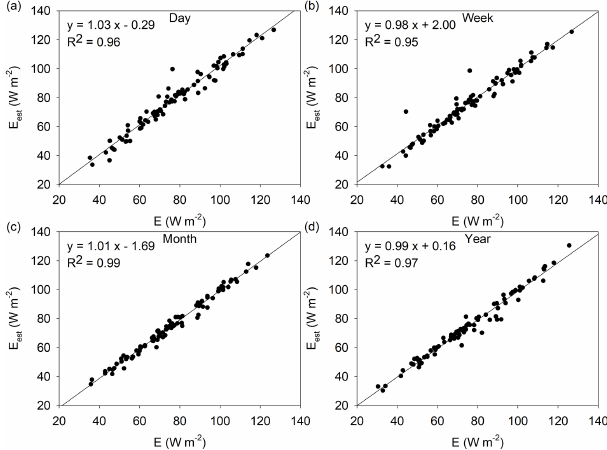
Figure 1. The estimated evaporation based on the SGC function (Eq. 1) vs. the observed site mean evaporation at the daily scale (a) , weekly scale (b) , monthly scale (c) , and yearly scale (d) . Each dot represents the site mean result ( N = 88 in each panel). The regres- sion equations and determination coefficients ( R 2 ) were calculated using the site mean results of the 88 EC sites. Table 1. The evaluation merits (NSE, R 2 , and RMSE in Wm − 2 ) of the two generalized complementary functions using the energy residual (ER) closure correction method. The subscripts H and B correspond to the SGC function proposed in Han and Tian (2018) and the PGC function proposed in Brutsaert (2015), respectively. Day Week Month Season Year NSE H